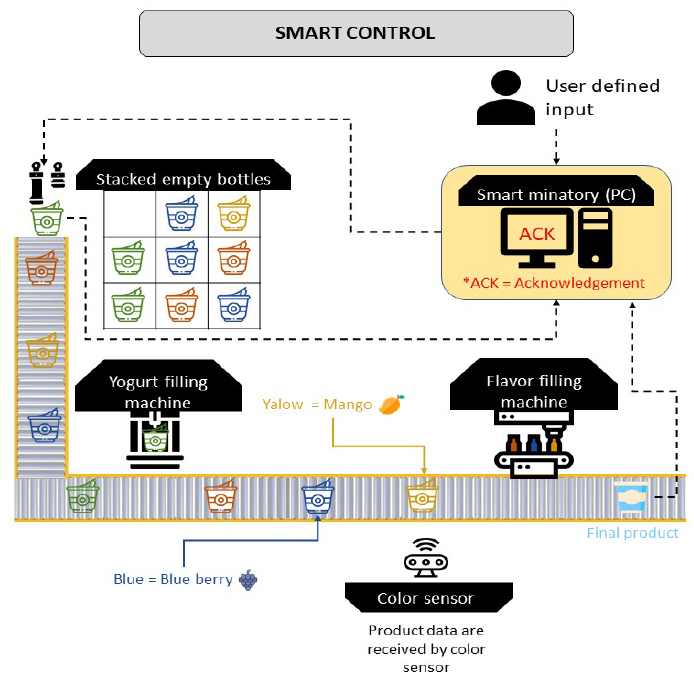
Figure 9. Production design layout. Figure 8. Production design